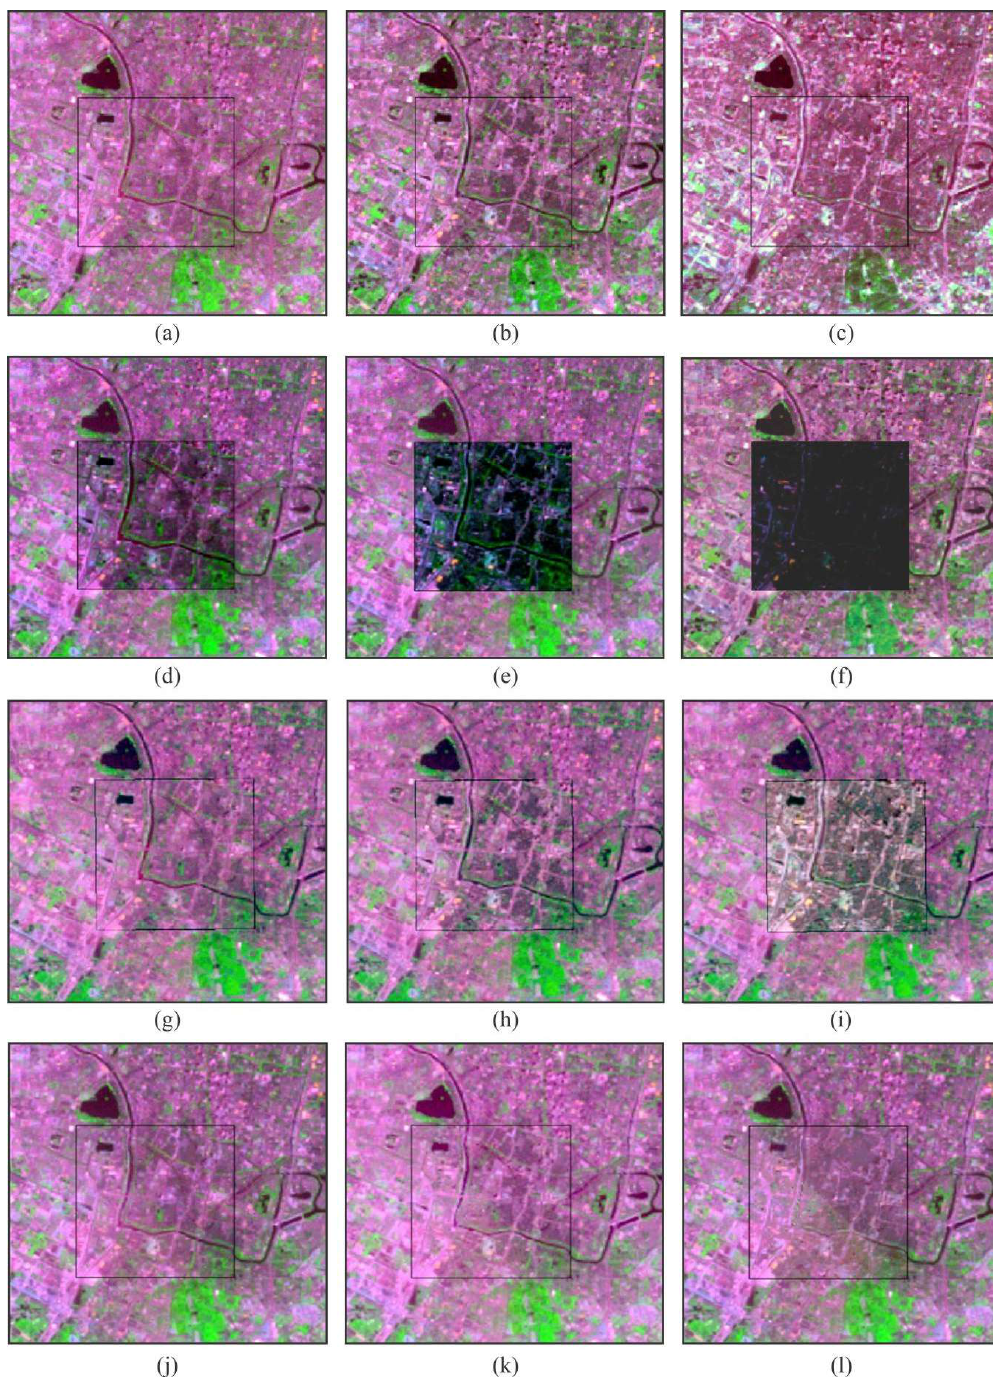
Figure 5. Reconstruction of the target TM image (p120r38) captured on DOY 140 using the three approaches with the reference image captured on DOY 124 for the 100 × 100 pixel patch (inside black line) in urban area (bands 1, 4 and 3 composited as RGB). ( a – c ) represent the reference images captured on DOY 124, 108 and 60 in the city area, respectively. ( d – f ) show the reconstructed images by the DR method using the reference image captured on DOY 124, 108 and 60, respectively. ( g – i ) are the reconstructed results by MSD method using the reference images captured on DOY 124, 108 and 60. ( j – l ) represent the reconstructed images by the LRM method using the reference images captured on DOY 124, 108 and 60. Cloud cover masks were made with cloudy pixels (inside the black line) set to 0 and cloud-free pixels (outside the black line) set to